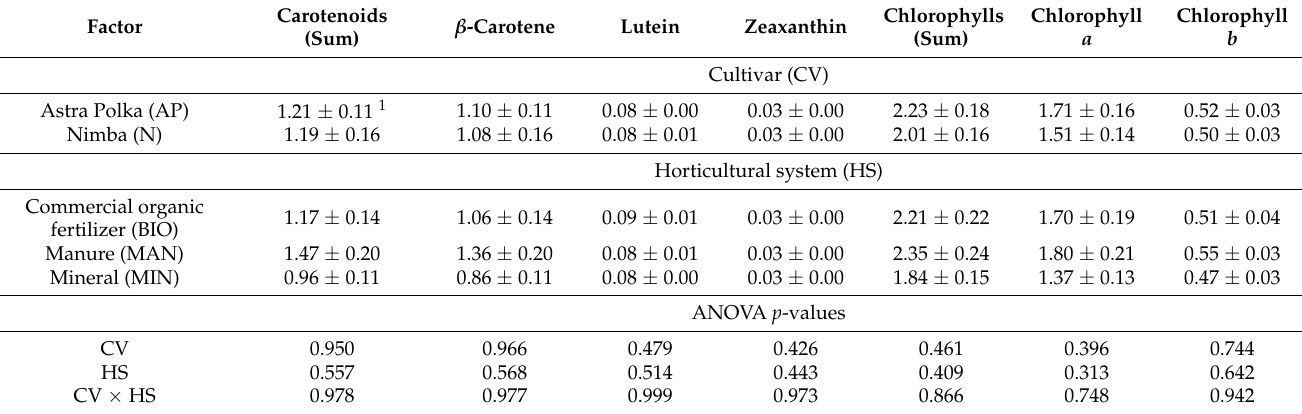
Table 5. The main effect of, and interaction between, cultivar and horticultural system on the content of carotenoids and chlorophylls (mg/100 g f.w.) in courgette